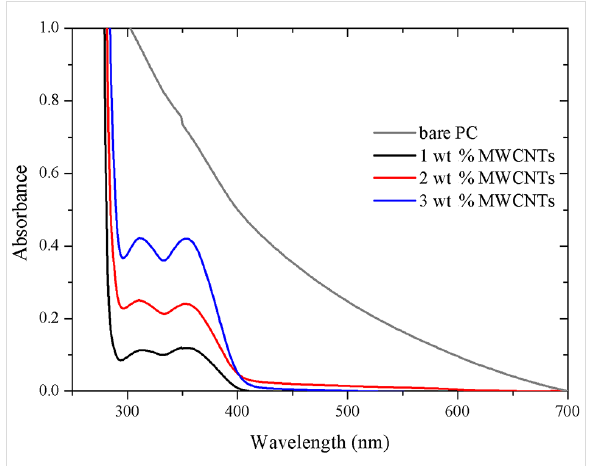
Figure 2: UV–vis absorbance of composite samples with different MWCNT